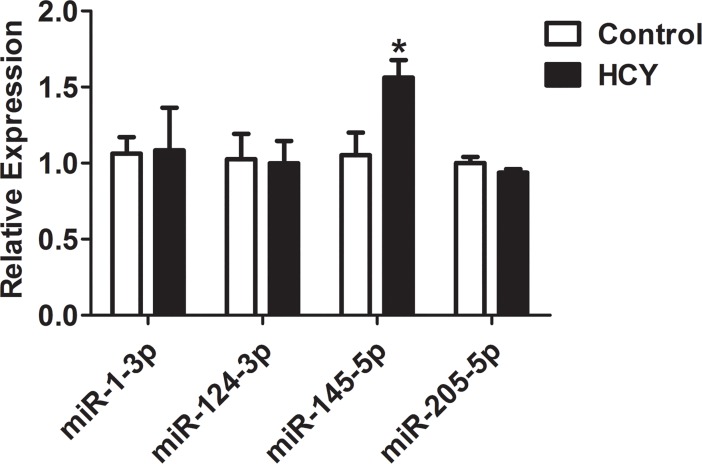
qRT-PCR analysis of miR-1-3p, miR-124-3p, miR-145-5p and miR-205-5p in Hcy-treated HUVECs.Only the miR-145-5p level increased significantly in the Hcy group compared with the control group. * P<0.05 when compared with control group.